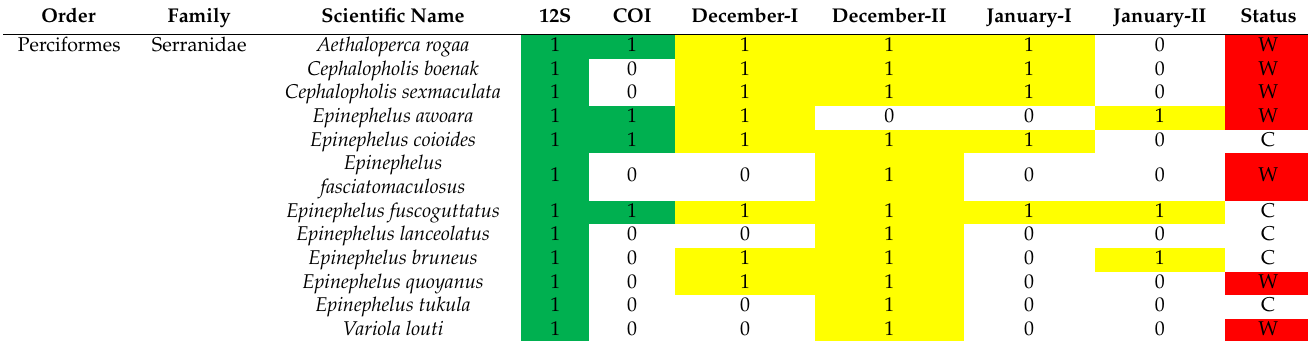
Note: Green colors highlight the presence of species identified by 12S and COI. Yellow colors highlight the presence of species identified in different sampling dates (December and January) and sites (I and II). Red colors highlight the wild species. W: Wild species; C; Culture